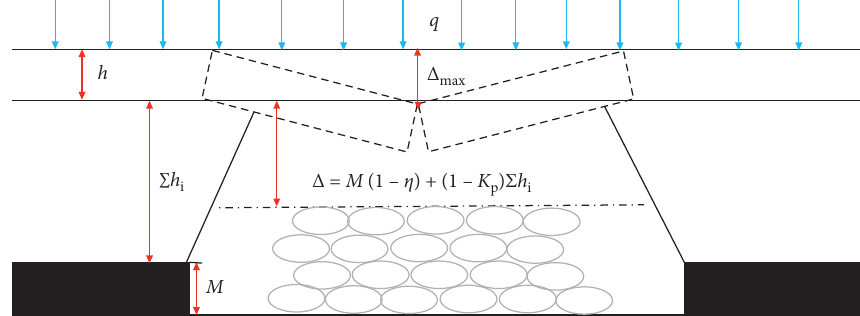
Figure 4: Breaking and rotation movement diagram of key stratum.